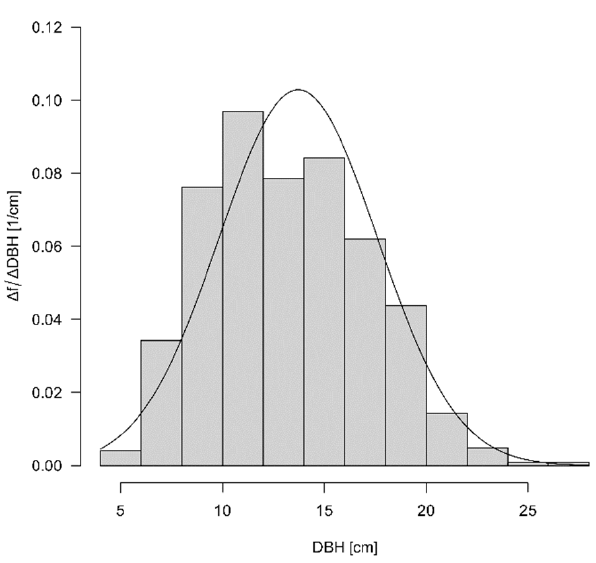
Figure 2. Distribution of all the tree diameters at breast height.